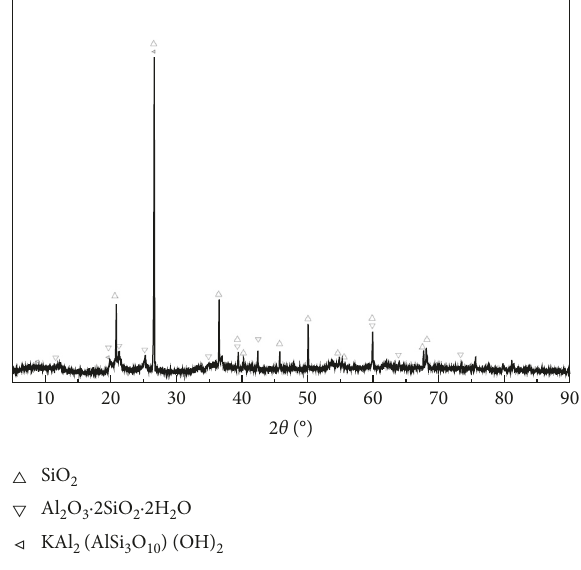
Figure 8: XRD patterns of cohesive clay.